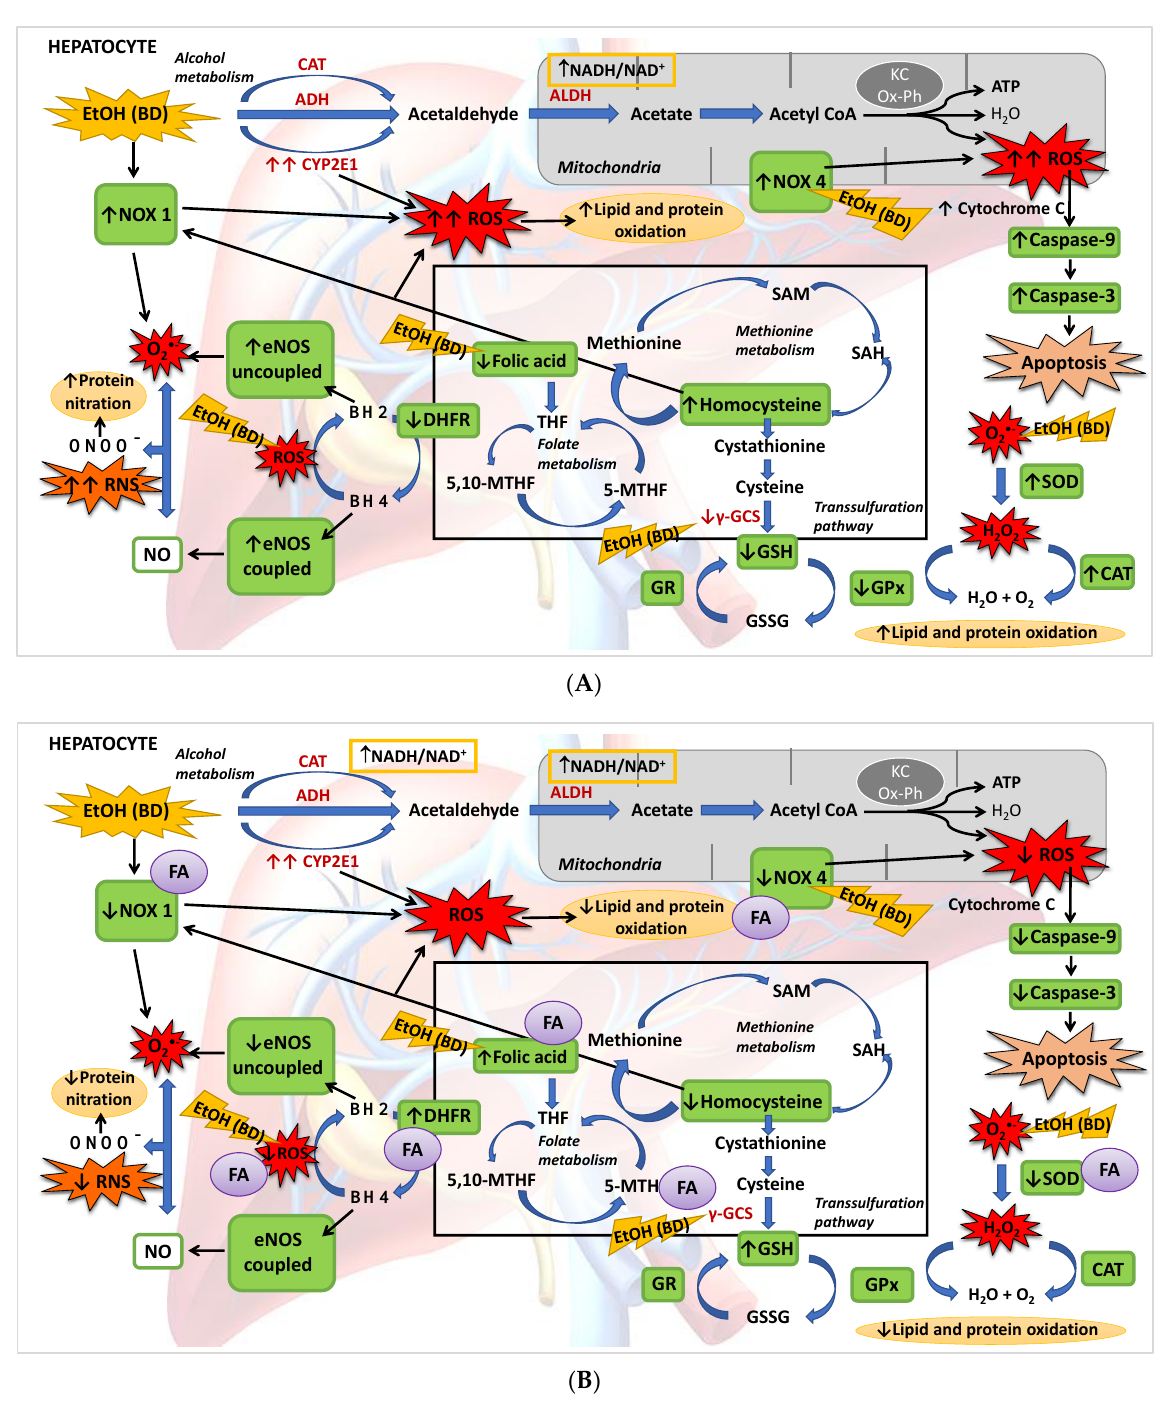
Figure 8. ( A ) BD in adolescence increases the hepatic production of ROS and RNS, causing oxidative and nitrosative stress leading to apoptosis. BD stimulates the pro-oxidant enzymes CYP2E1 and NOX1, increasing cytosolic ROS generation, and NOX4 activity, increasing ROS mitochondrial generation and cytochrome C expulsion, contributing to apoptosis. BD affects the antioxidant enzymatic defense system, increasing SOD and CAT activities and decreasing GPx activity, but lipid and protein oxidation appears. BD affects the methionine cycle and the transsulfuration pathway, leading to depletion in GSH levels and HHcy. BD reduces the expression of DHFR, decreasing the cofactor BH4 and increasing the uncoupled form of eNOS, producing RNS and protein nitration. BD also leads to a hepatic depletion of FA, which could be implicated in all these actions. ( B ) FA antioxidant pathways against hepatic oxidation induced by BD in adolescence. FA supplementation to BD rats manages to reduce the oxidation of lipids and proteins, as well as protein nitration and apoptosis. It decreases the expression of the pro-oxidant enzymes NOX1 and NOX4, avoiding ROS generation and apoptosis. FA restores the balance of the antioxidant enzymatic defense system. Due to its participation in the methionine cycle and the transsulfuration pathway, it increases the levels of the antioxidant GSH and decreases the pro-oxidant Hcy. FA also increases the expression of DHFR and BH4 viability, increasing the stability of coupled eNOS, avoiding RNS generation and nitrosative damage. Author Contributions: Conceptualization, M.L.O. and M.d.C.G.-L.; methodology, F.N. and M.d.C.G.-L.; validation, M.L.O., F.N. and O.C.; formal analysis, F.N., M.L.O. and M.d.C.G.-L.; investigation, I.R.-H., F.N. and M.d.C.G.-L.; resources, O.C.; data curation, M.L.O.; writing — original draft preparation, M.d.C.G.-L. and M.L.O.; writing — review and editing, M.d.C.G.-L., I.R.-H. and M.L.O.; supervision, M.L.O., F.N. and O.C.; management of references, M.d.C.G.-L.; figure design, M.d.C.G.-L. and M.L.O.; funding acquisition, O.C. All authors have read and agreed to the published version of the manuscript. Funding: This research was funded by the Andalusian Regional Government for its support to the CTS-193 research group. Institutional Review Board Statement: Animal care procedures and experimental protocols were conducted according to the EU regulations (Council Directive 86/609/EEC, 24 November 1986), and they were approved by the Ethics Committee of the University of Seville. Informed Consent Statement: Not applicable. Data Availability Statement: Data is contained within this article.